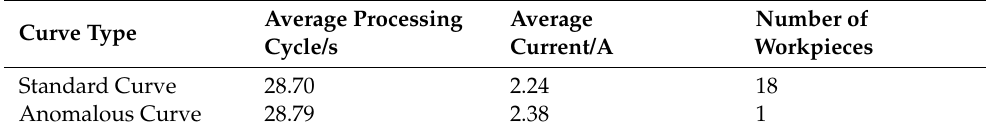
Table 5. Comparison of tool crash anomaly.